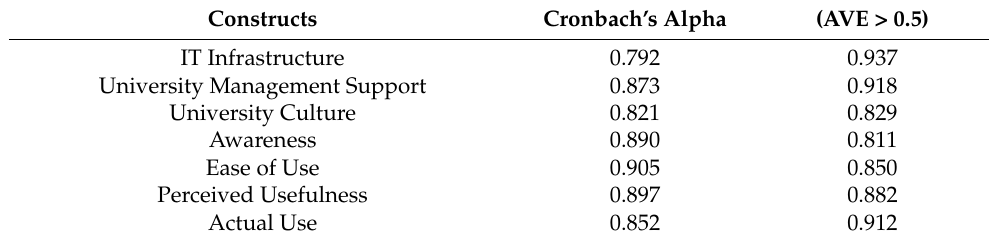
Table 2. Reliability and convergent validity analyses.